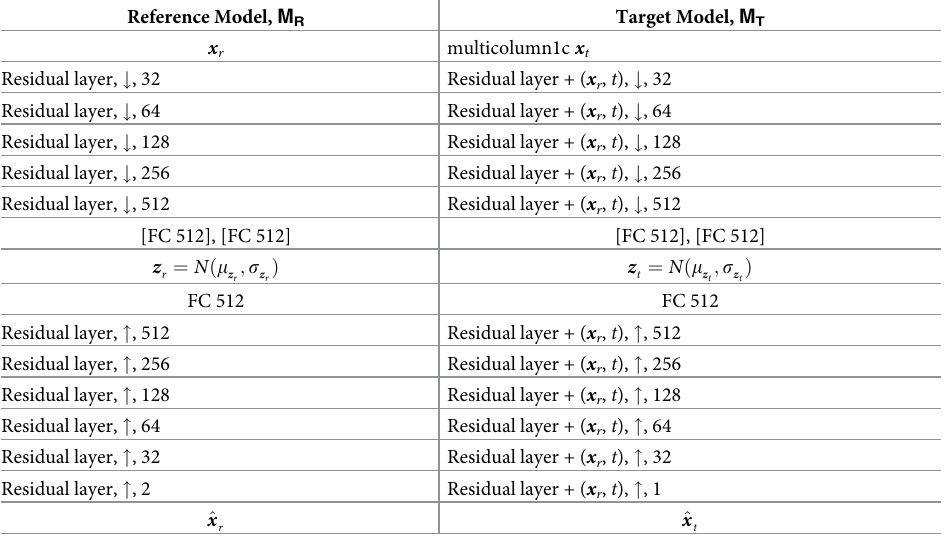
Table 3. Architecture of model used in this study. Arrows indicate spatial downsampling or